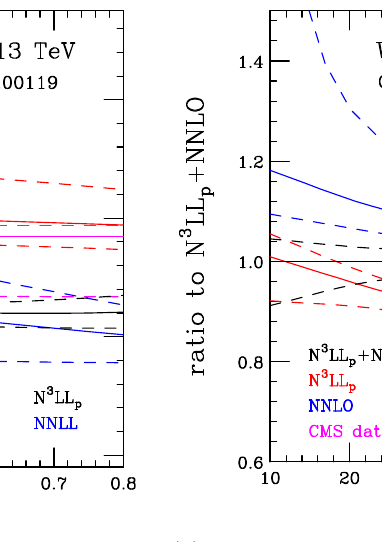
Figure 12 . Comparison of NNLO , N 3 LL p and matched N 3 LL p + NNLO results for W + W −